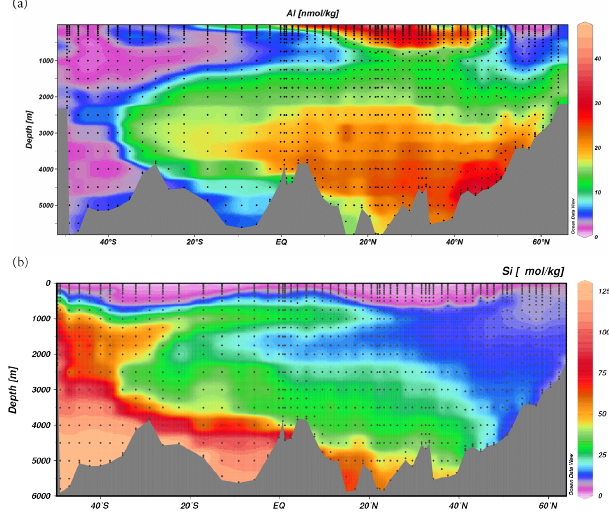
Figure 1. Observations of (a) [ Al diss ] (nmolkg − 1 ) and (b) [ Si ] (µmolkg − 1 ) at the West Atlantic GEOTRACES transect diss (Middag et al., 2014). Dots are the locations of the